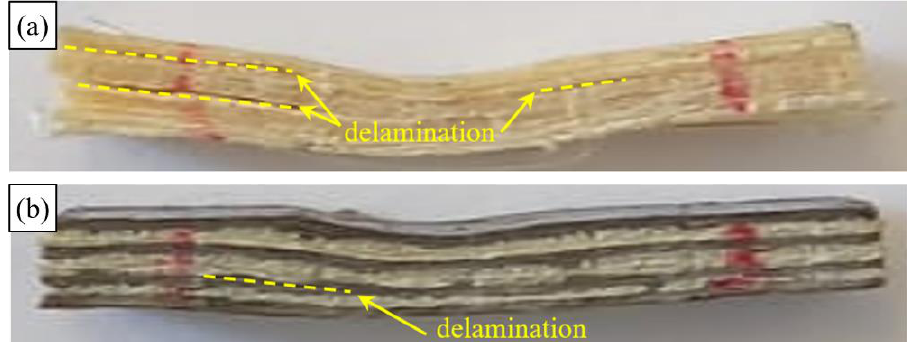
Figure 18. Typical failed ILSS specimen aged after 1008 h: ( a ) SFRP and ( b ) B-SFRP.